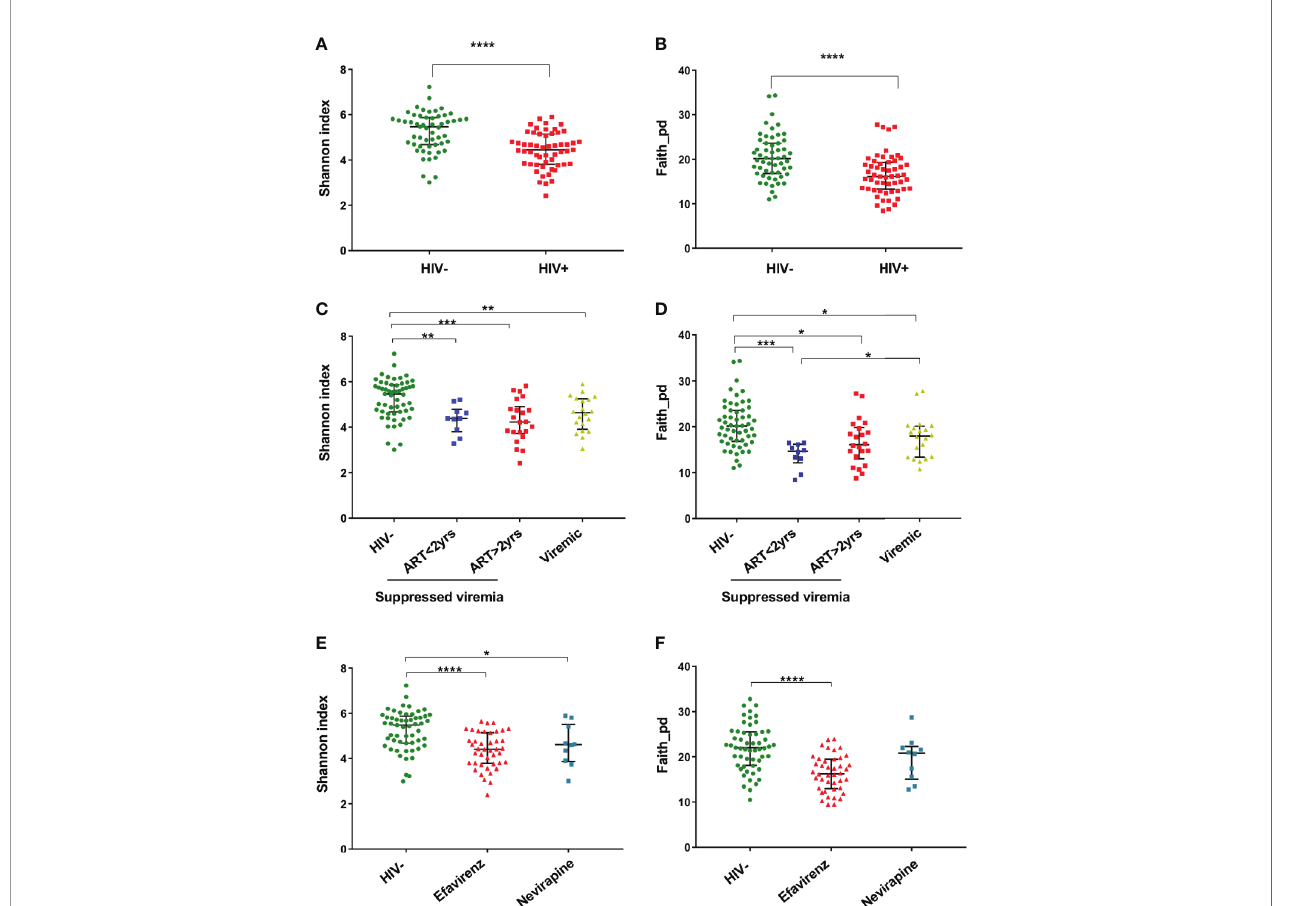
FIGURE 2 | Alpha diversity of fecal microbiome in HIV-1 uninfected and infected Ghanaian adults. (A) Comparison of Shannon diversities of fecal microbiome between HIV- (n = 55) and HIV+ (n = 55). HIV- showed signi fi cantly higher diversity than HIV+ ( p < 0.001). (B) Comparison of Faith phylogenetic diversities between HIV- and HIV+. HIV- showed signi fi cantly higher diversity than HIV+ ( p < 0.001). (C) Comparison of Shannon diversities among HIV-, HIV-1 infected controllers (viral load < 1,000 copies/ml) under ART for less than 2 years (ART<2 yrs, n = 10), HIV-1 infected controllers under ART for more than 2 years (ART>2 yrs, n = 22), and HIV-1 infected non-controllers (viral load > 1,000 copies/ml) under ART (Viremic, n = 20). HIV- showed signi fi cantly higher diversity than ART<2yrs ( p < 0.01), ART>2yrs ( p < 0.005), and Viremic ( p < 0.01), respectively. (D) Comparison of Faith phylogenetic diversities among HIV-, ART<2 yrs, ART>2 yrs, and Viremic. HIV- showed signi fi cantly higher diversity than ART<2yrs ( p < 0.005), ART>2yrs ( p < 0.05), and Viremic ( p < 0.05), respectively. ART<2yrs showed signi fi cantly lower diversity than Viremic ( p < 0.05). (E) Comparison of Shannon diversities among HIV-, HIV+ on ART with Efavirenz (n = 42), and HIV+ on ART with Nevirapine (n = 10). (F) Comparison of Faith phylogenetic diversities among HIV-, HIV+ with Efavirenz, and HIV+ with Nevirapine. Signi fi cant difference was determined by Wilcoxon rank sum test (A, B) or Kruskal Wallis test with Benjamini, Krieger and Yekutieli FDR correction (C – F) ; *, **, ***, and **** indicate signi fi cant differences with p < 0.05, p < 0.01, p < 0.005, and p < 0.001,